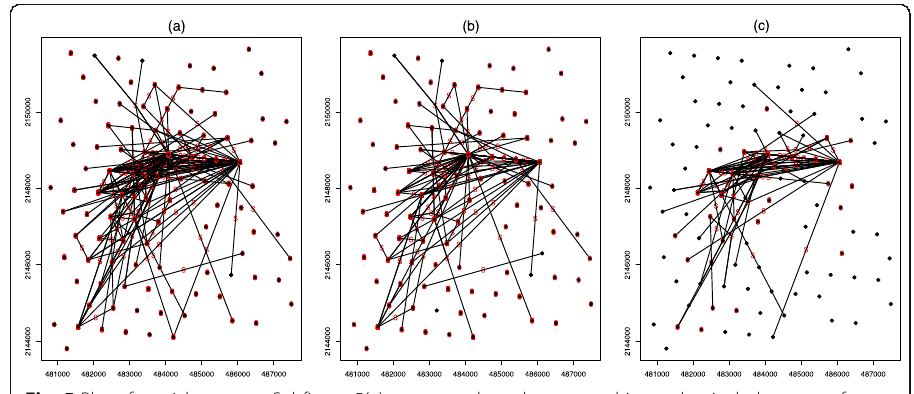
Fig. 5 Plot of spatial captures. Subfigure 5( a ) corresponds to the capture history that includes users of social networks in general and users who support the march (total number of individuals = 2051, number of traps =100, number of occasions = 24). Additionally, Subfigure 5( b ) and 5( c ) shows, only for visualization purposes, the capture history of subfigure 5( a ) according to the Type of User individual covariate. Subfigure 5( b ) describes the capture history of Generic social media users ( n = 1991); and finally, subfigure 5( c ) describes the capture history of social media users Supporting the march ( n